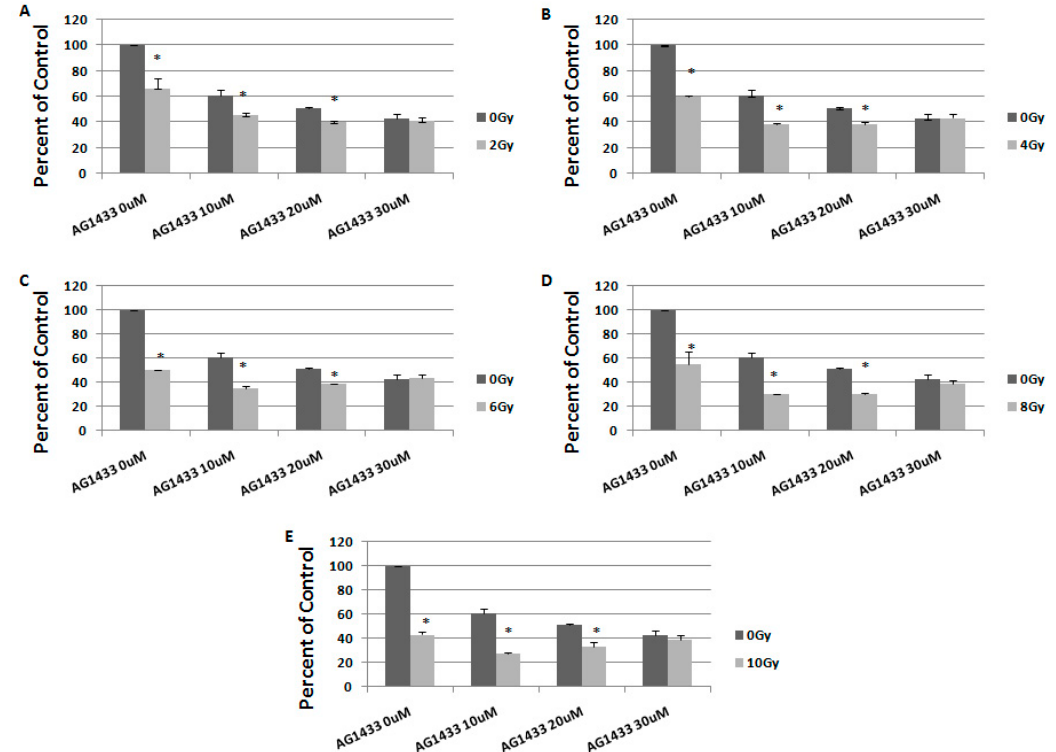
Figure 6. The effect of PDGFR inhibition on ionizing radiation response in 11 HGG cells, 7 days after treatment. The cells were seeded in 96-well culture plates (3000 cells/well) then irradiated with 2 Gy ( A ); 4 Gy ( B ); 6 Gy ( C ); 8 Gy ( D ); 10 Gy ( E ) and treated with 10, 20, or 30 µM AG556. The cells were incubated for 3 days and cell viability was determined by MTT assay. All results show the mean of three independent experiments ± SD, * p < 0.05 vs. irradiated cells.